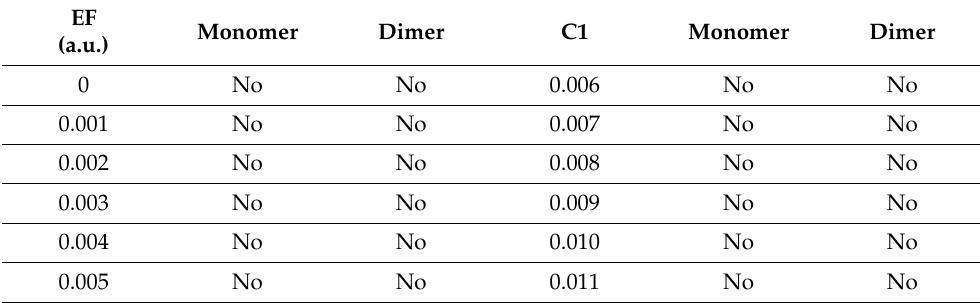
Figure 1. The molecular structure of ENB-EPDM (Ethylene-propene-ethylene-norbornene). Table 1. Breakdown of molecules with different DPs under electric field (EF).